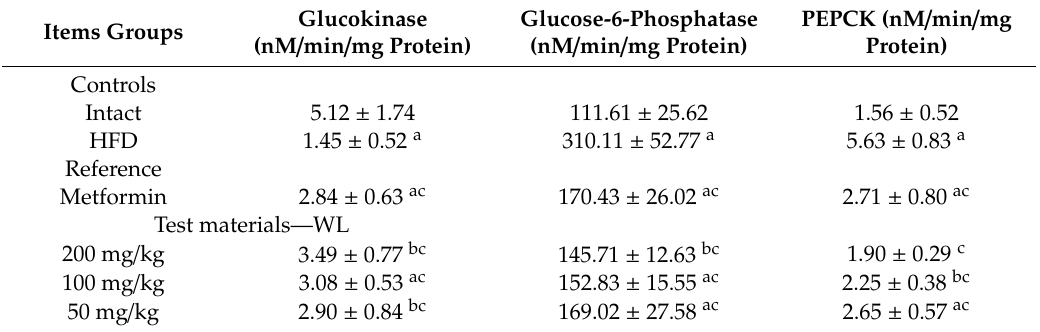
Table 15. Changes in the hepatic glucose-regulating enzyme activities in NFD or HFD supplied